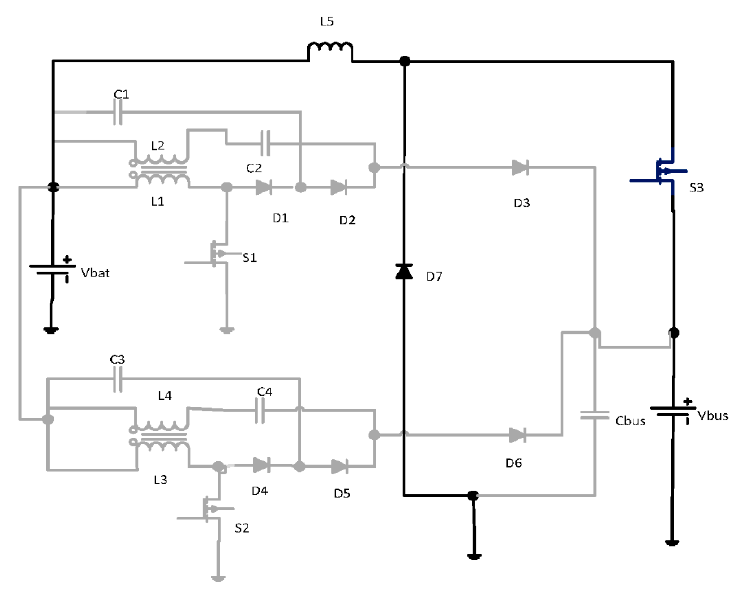
Figure 3. Step-down converter.